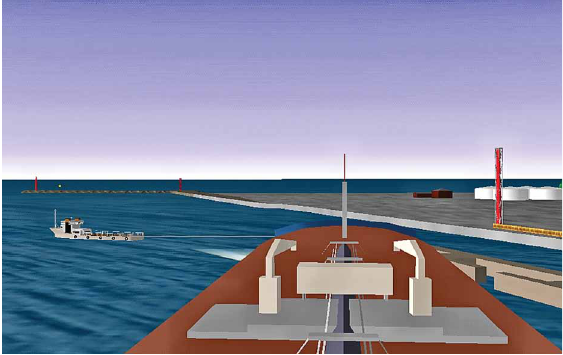
Fig. 5. Visual picture of ship unberthing and maneuvering